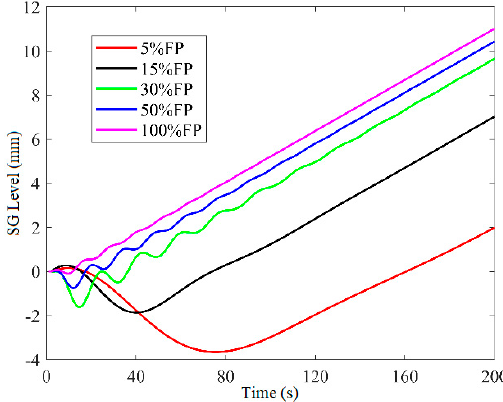
Figure 10. Curve of level response for step flowrate in feedwater at different powers.